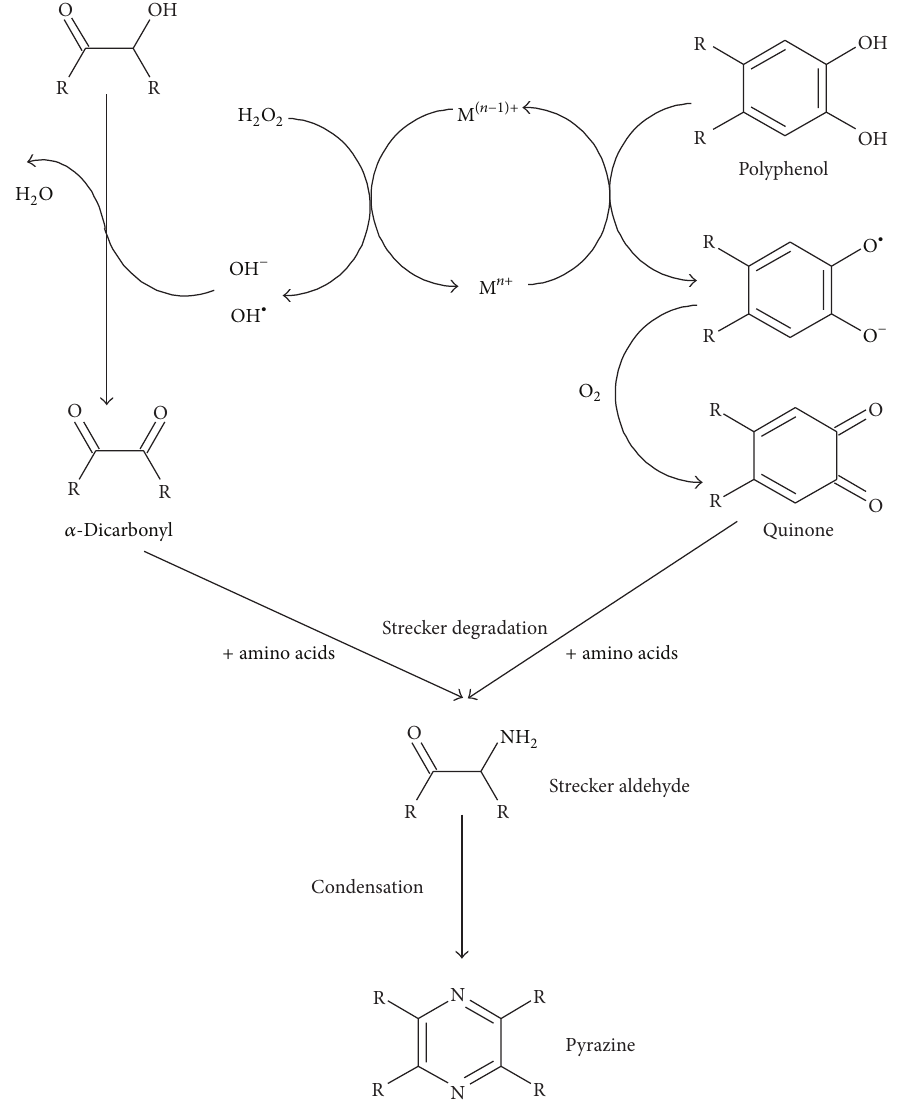
Figure 3: Reaction pathways proposed to explain the higher formation of pyrazines exerted by polyphenols of the studied seasoning. Adapted from [2, 15,